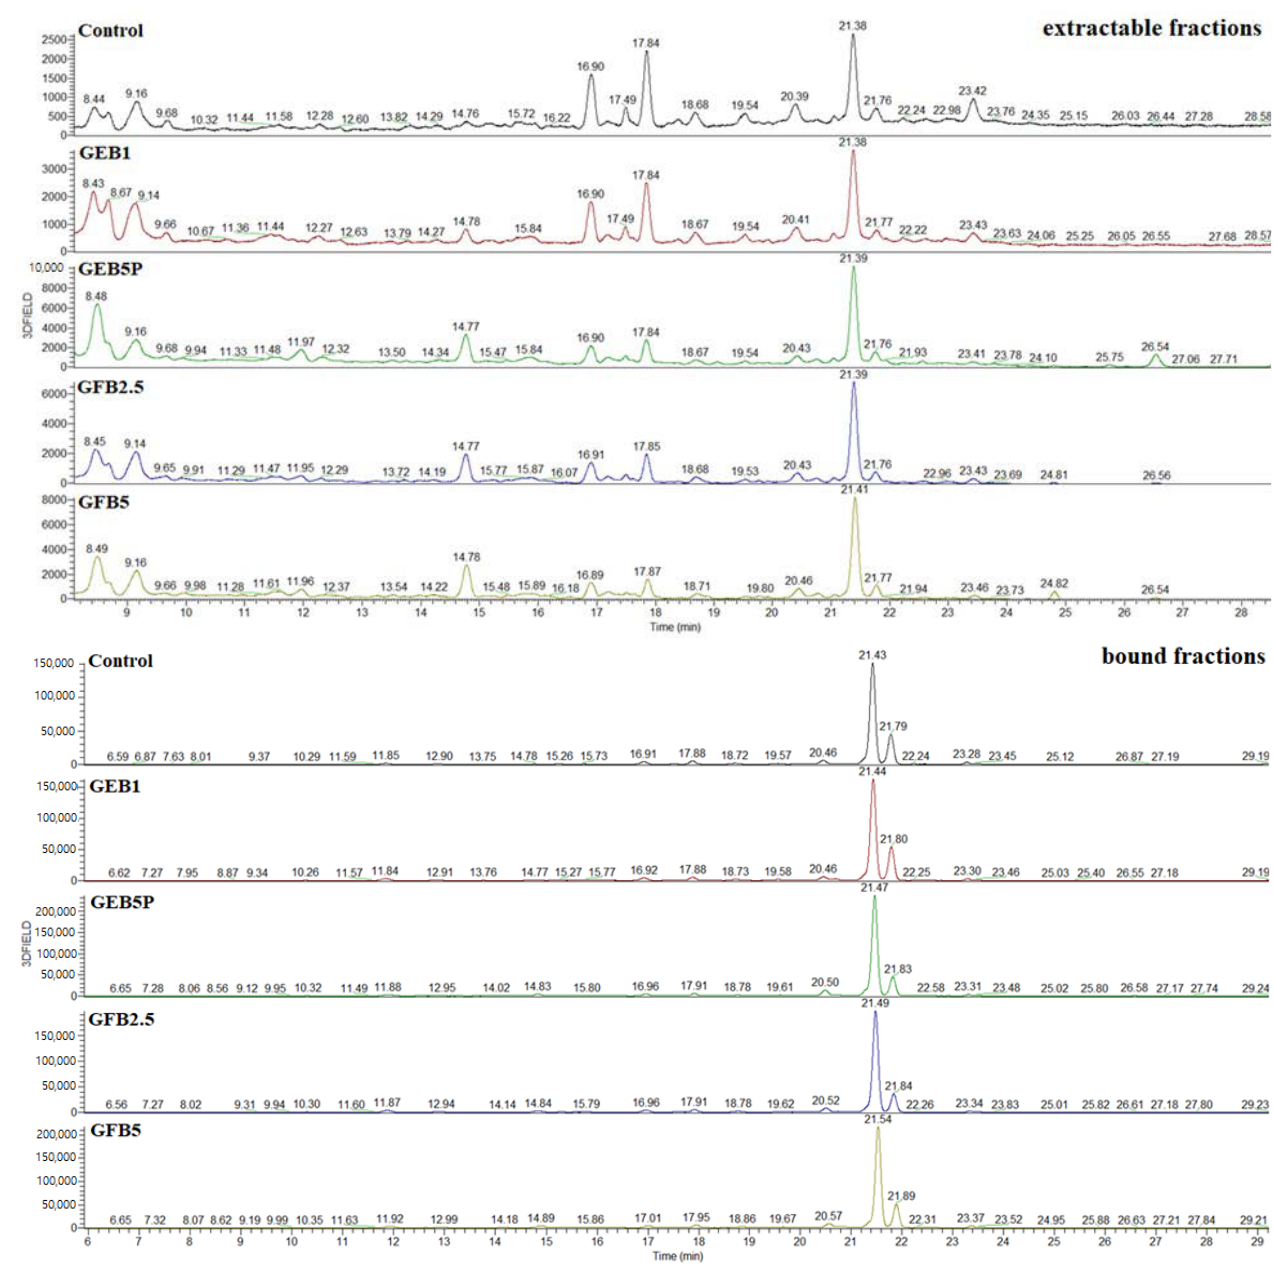
Figure 3. HPLC-MS chromatograms of the extractable and bound fractions of the control and bioprocessed breads (detected at 310 nm). Control: white wheat bread; GEB1: wheat bread supplemented with 1% “germinated + enzymatic treated” spelt flour; GEB5P: wheat bread supplemented with 5% pasteurised (30 min, 85 °C) “germinated + enzymatic treated” spelt flour; GFB2.5: wheat bread supplemented with 2.5% “germinated + fermented” spelt flour; GFB5: wheat bread supplemented with 5% “germinated + fermented” spelt flour.